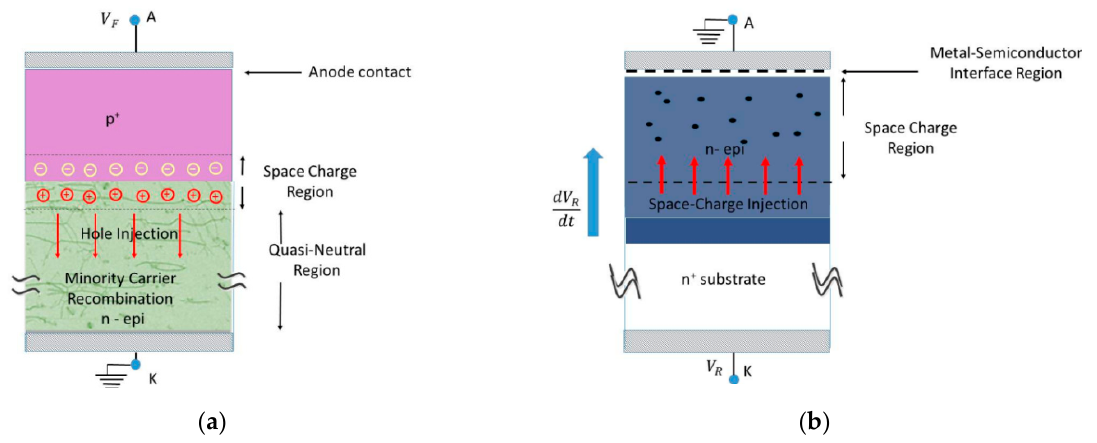
Figure 1. Potential mechanisms for defect excitation in a ( a ) forward-biased bipolar semiconductor diode junction, and ( b ) a unipolar Schottky barrier diode junction [25].